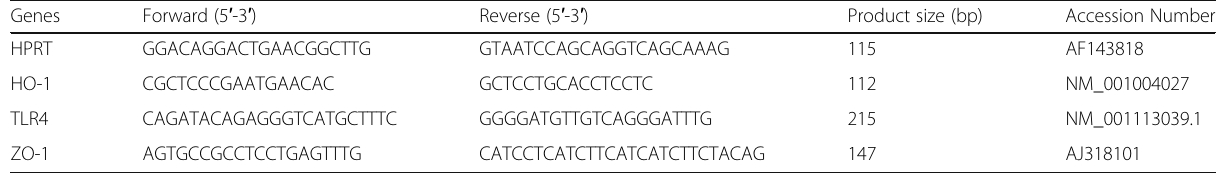
Table 1 Primer sequence used for quantitative Real Time PCR analysis Genes Forward (5 ′ -3 ′ ) Reverse (5 ′ -3 ′ ) Product size (bp)